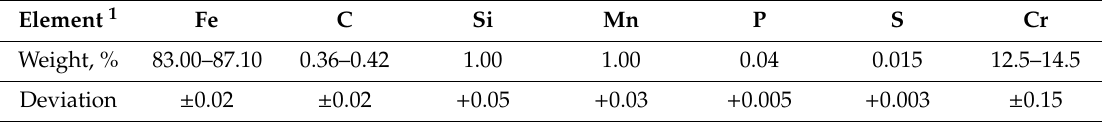
Table 2. Chemical composition of X39CR13 high carbon martensitic stainless steel.